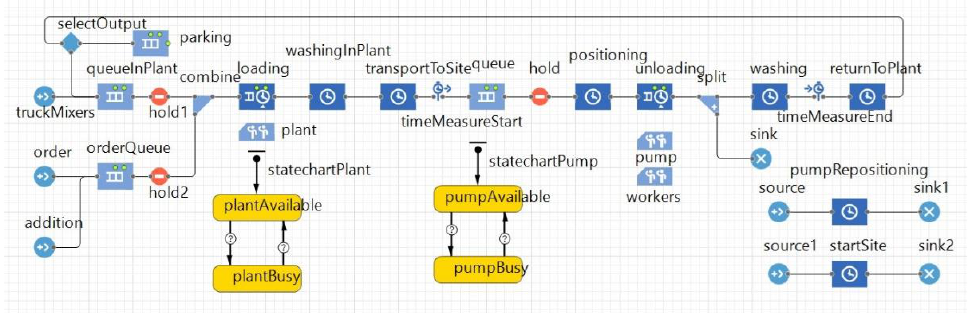
Figure 2. Concreting process diagram with state charts – simulation model.